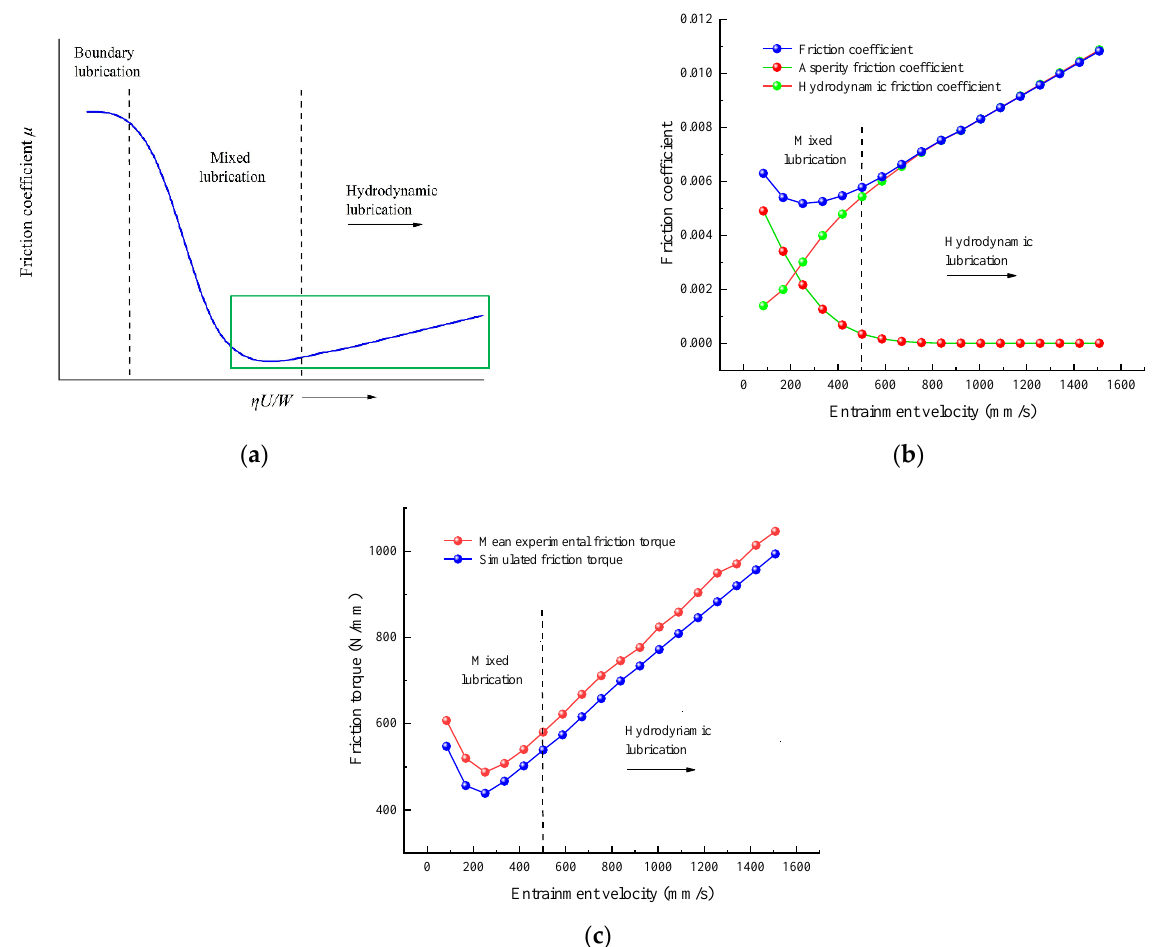
Figure 6. Results of the friction torque test. ( a ) A schematic Stribeck curve [34]. ( b ) Friction coefficient curve. ( c ) Comparison of the simulated and experimental friction torque.